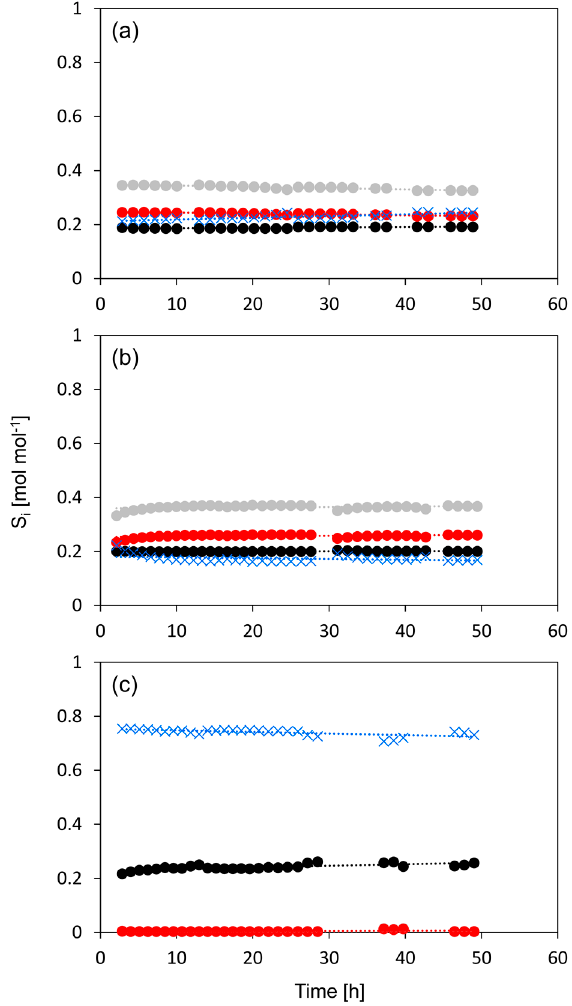
Figure 9. Selectivity to the dehydration products of n-butanol versus time on stream, for n-HZSM-5 ( a ) Hybrid-50 / 50 ( b ) and γ -Al 2 O 3 ( c ). 1-butene ( • , black), cis-2-butene ( • , red), trans-2-butene ( • , grey), dibutyl ether ( × , blue). Temperature = 513 K, inlet pressure of n-butanol = 29 kPa, total pressure = 5